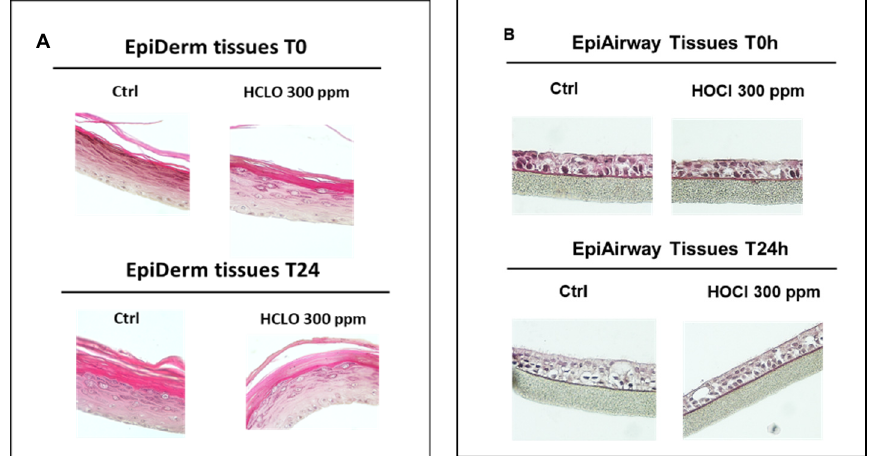
Figure 9. Epiderm ( A ) and Epiairway ( B ) tissue morphology evaluation by hematoxylin–eosin staining in control tissues and in tissues immediately after or 24 h after 300 ppm HOCL nebulization. Magnification 40×.